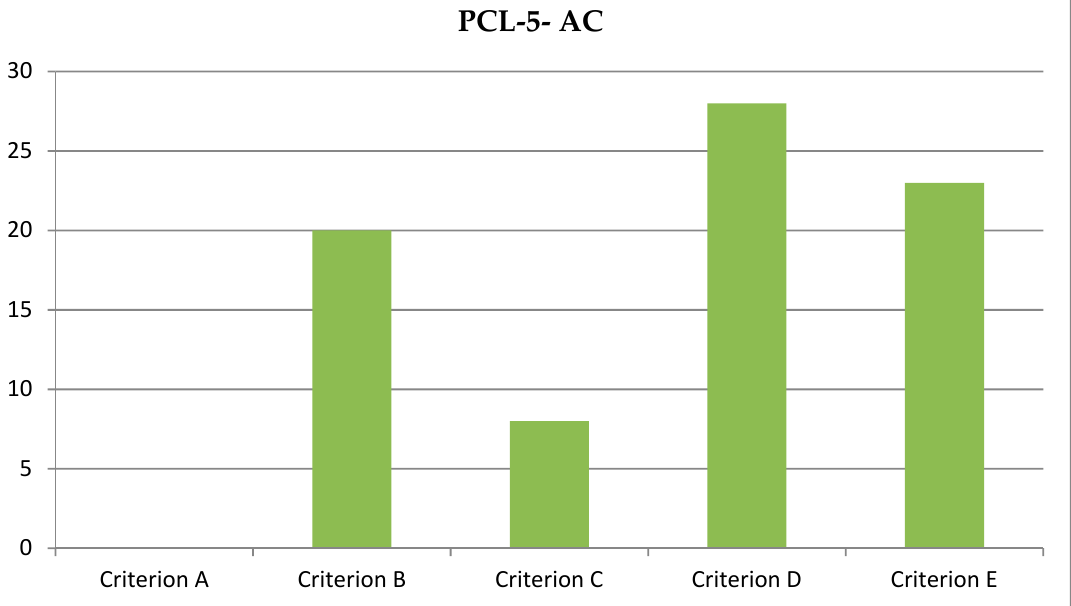
Figure 2. PTSD-After Cesarean (AC) Criteria.